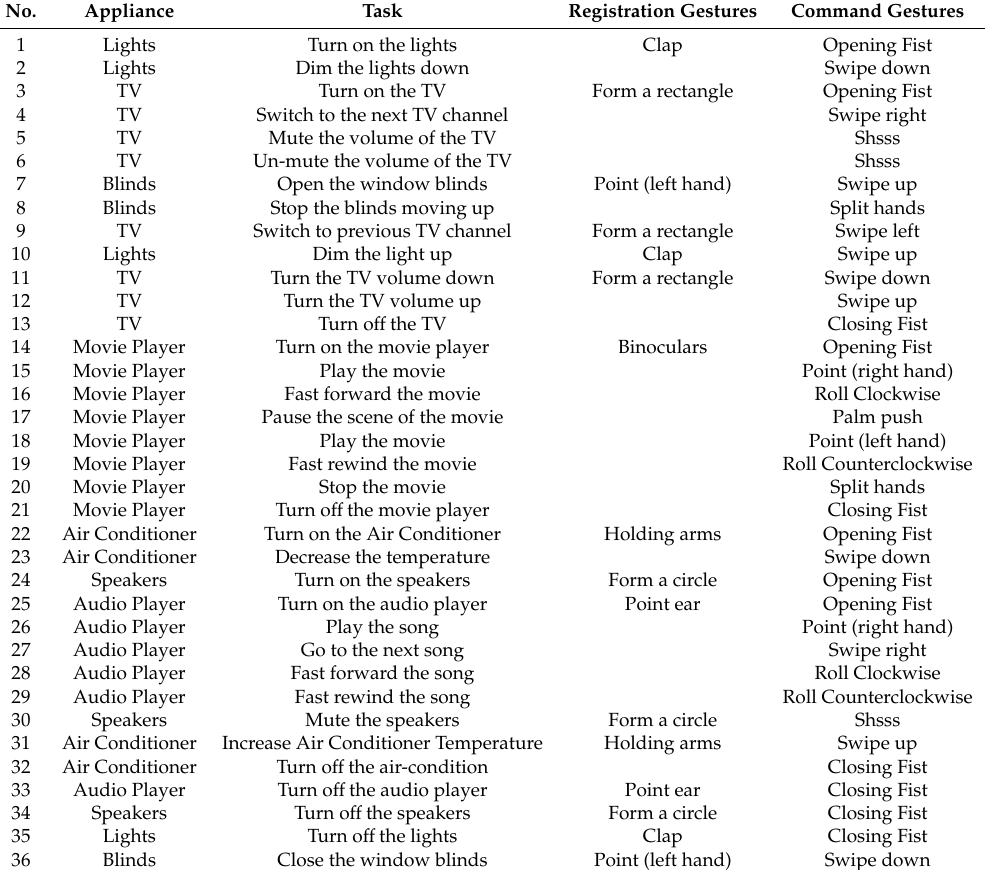
Table 2. Scenario used for the evaluation of the prototype and the corresponding gestures needed for registering and commanding